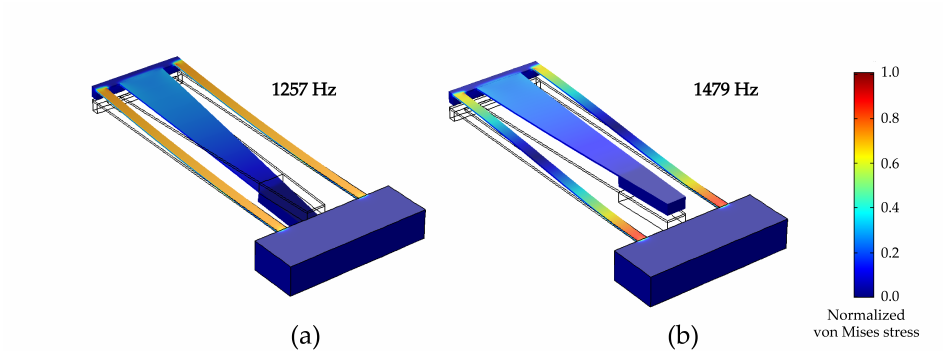
Figure 5. Mode shapes of ( a , b ) M-shape at the first and second natural frequencies. The gradient on the side displays the normalized von Mises stress on the cantilever beams without the lead zirconate titanate (PZT) piezoelectric layer.